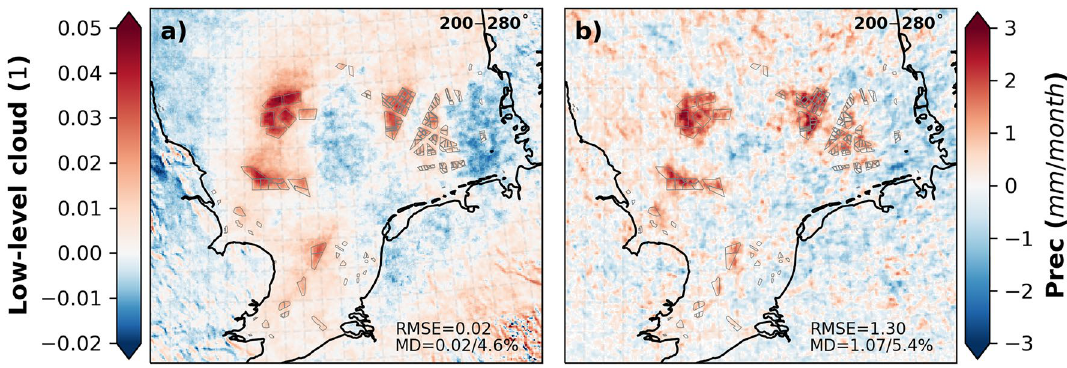
Figure 9. Annual mean difference between the CCLM_WF and CCLM for ( a ) low cloud amount and ( b ) total precipitation outside and inside the wind farms for the prevailing wind directions of 200–280° in 2008–2017. Root mean square errors (RMSE) and mean differences (MD) over the wind farm areas in 2008–2017 are given in the legend. This figure was created with Matplotlib (Hunter, J. D., Matplotlib: a 2D graphics environment. Computing in Science and Engineering 9, 2007) and Cartopy (Met office, Cartopy: a cartographic python library with a matplotlib interface. Exeter, Devon, https:// scito ols. org. uk/ carto py,